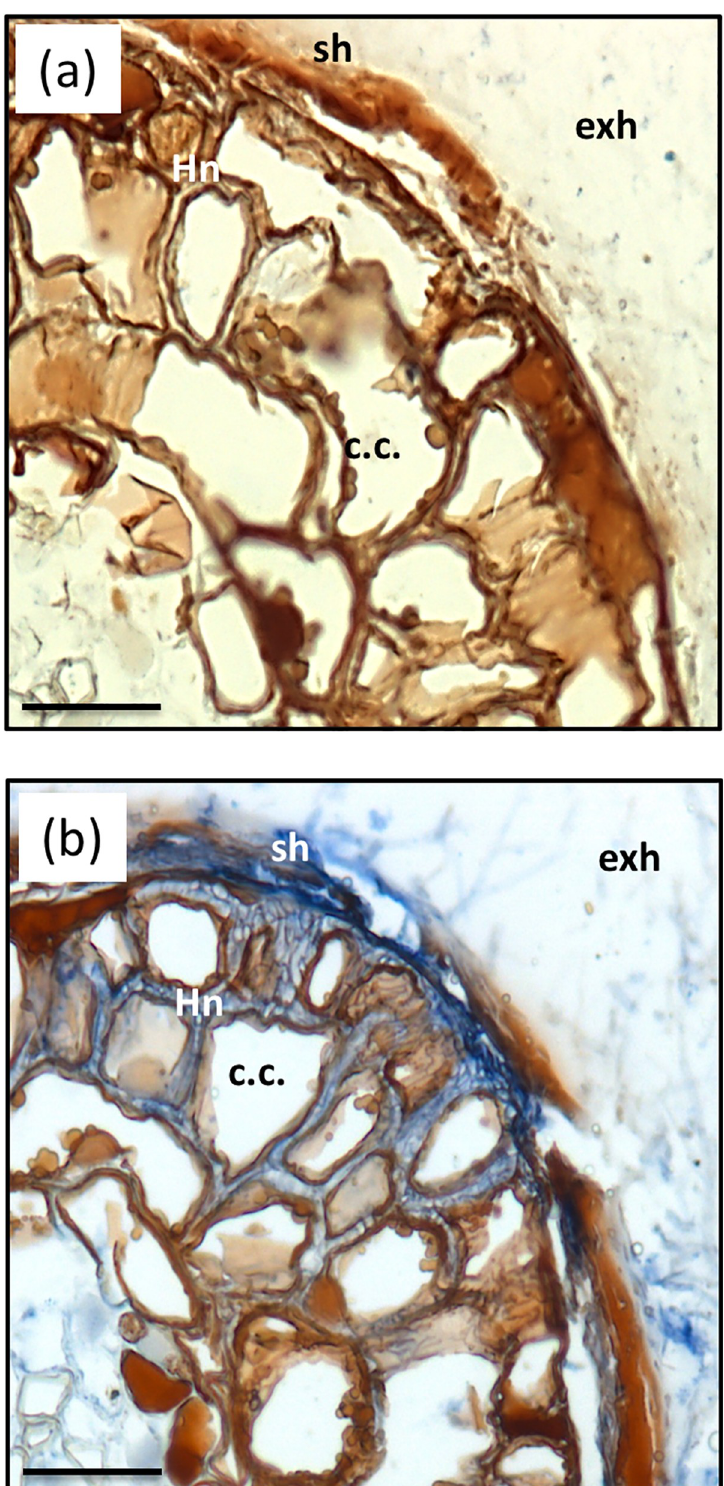
Fig 3. HcSKC transcript localization in Hebeloma cylindrosporum — Pinus pinaster ectomycorrhizas. In situ hybridization in ectomycorrhizas from 2-month-old co-cultures of P pinaster – H . cylindrosporum with HcSKC -specific probes. (a) Control with a sense probe did not show any signal. (b) Using the antisense probe, HcSKC transcripts were